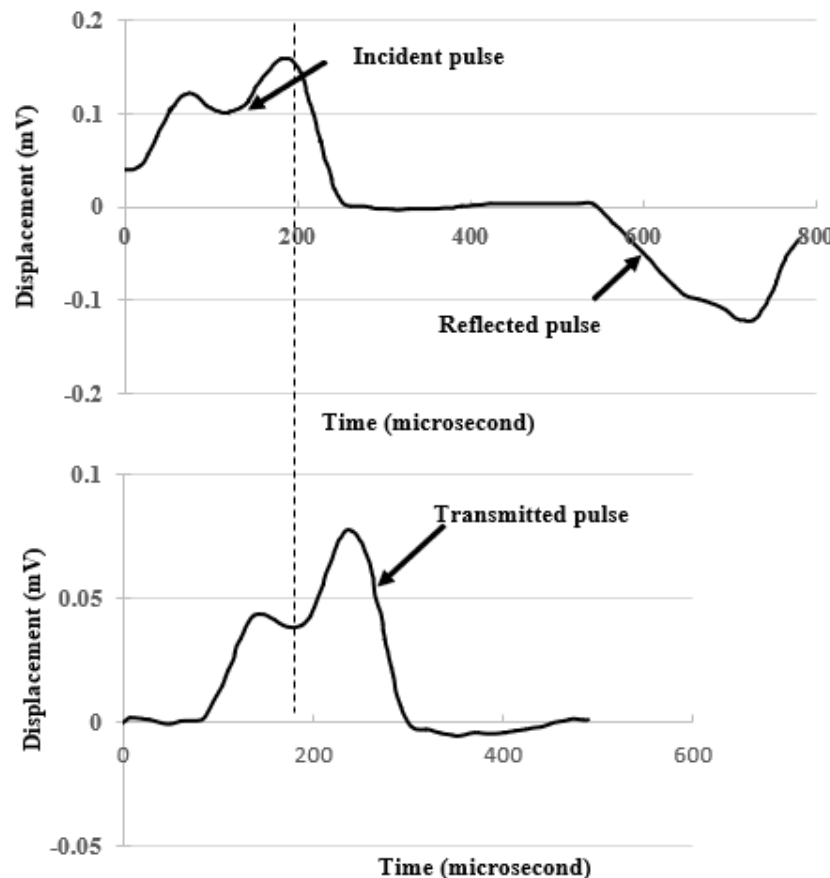
Figure 3. Displacement time-history records of the incident, reflected and transmitted pulses during the test.